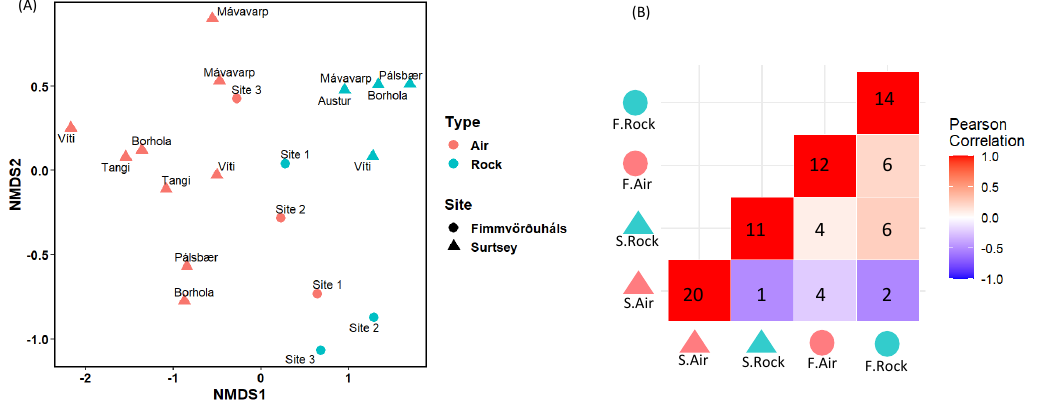
Figure 6. ( A ) NMDS ordination of the cultivable microbial community composition in the different stations of the sampling sites, based on the different genera cultivated from the air samples and the one-year-old lava rock samples. The ANOSIM statistic R and the significance for the type of sample, the sites, the stations, and the years were 0.5851/0.0001, 0.1063/0.1104, − 0.1713/0.8798, and 0.07837/0.1496, respectively. ( B ) Pearson correlation matrix based on the cultivated genera for each sampling. Numbers represent the cultivated genera in the one-year-old lava rocks of Surtsey (S. Rock), the one-year-old lava rocks of Fimmvörðuh á ls (F. Rock), the air of Surtsey (S. Air) the air of Fimmvörðuh á ls (F. Air), and those in common between these samples. Statistical analyses were performed on RStudio using R (v